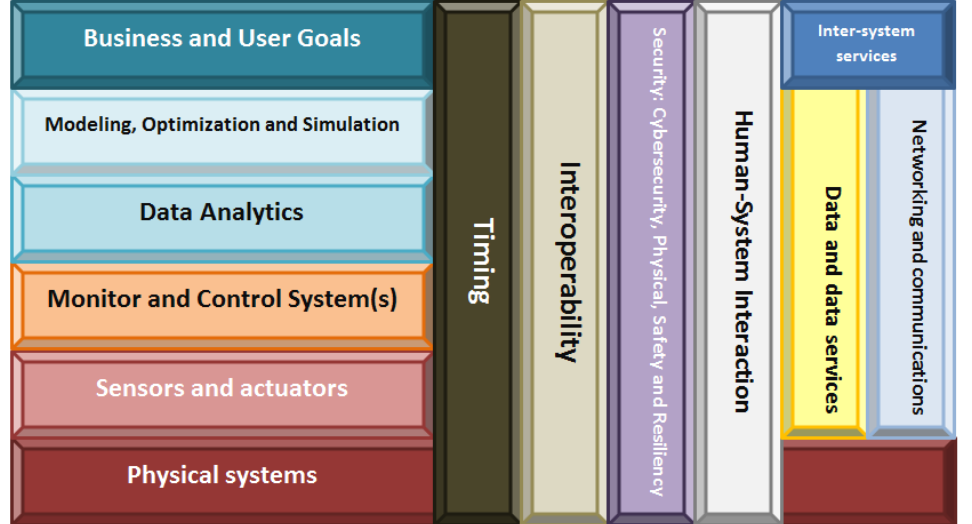
Figure 1. Reference CPS architecture